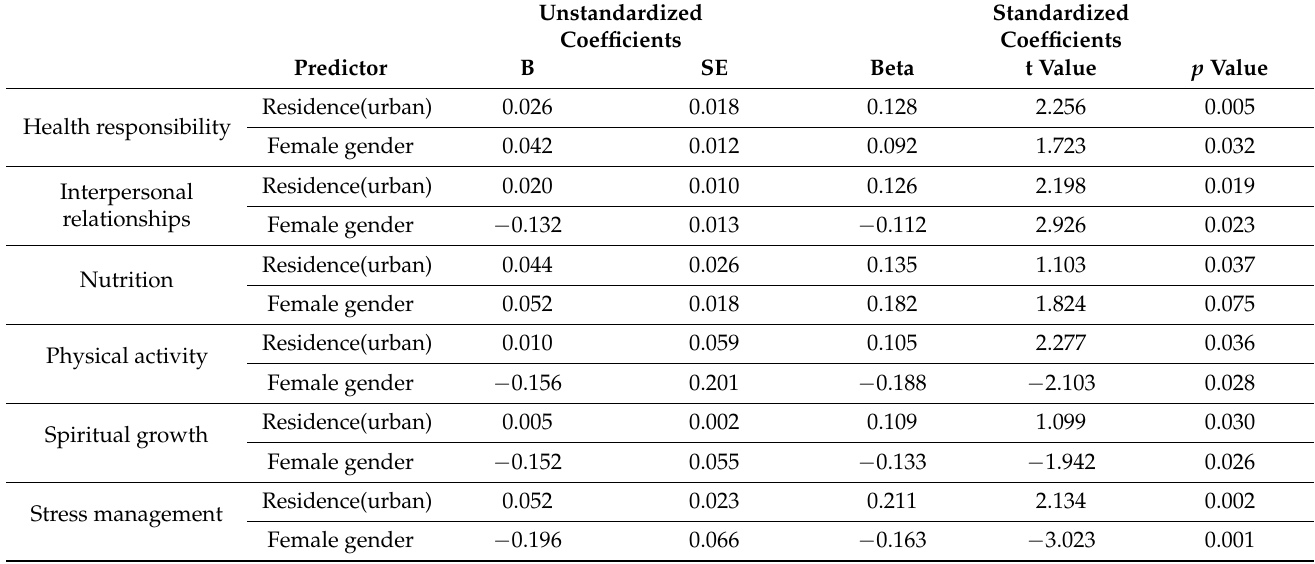
Table 6. Multiple regression analysis of predictors for HPLP II subcategories and demographic characteristics.